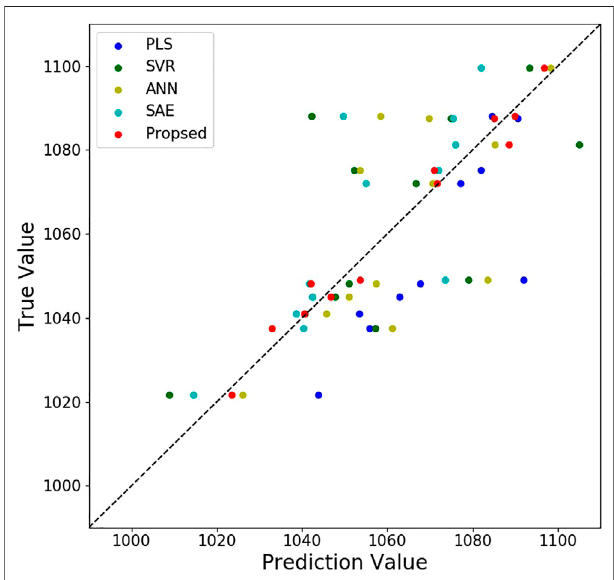
FIGURE 5 | Prediction and true values of different soft-sensor methods on the test set.